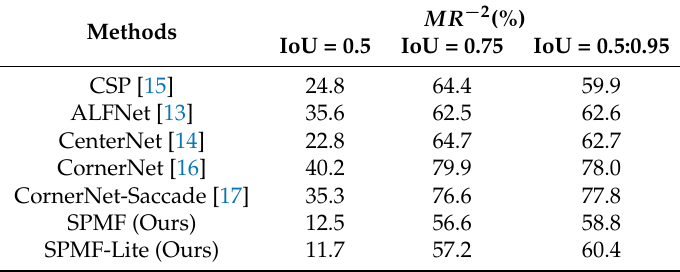
Table 3. Comparison with the state-of-the-art on low-light CityPersons (End-to-end testing